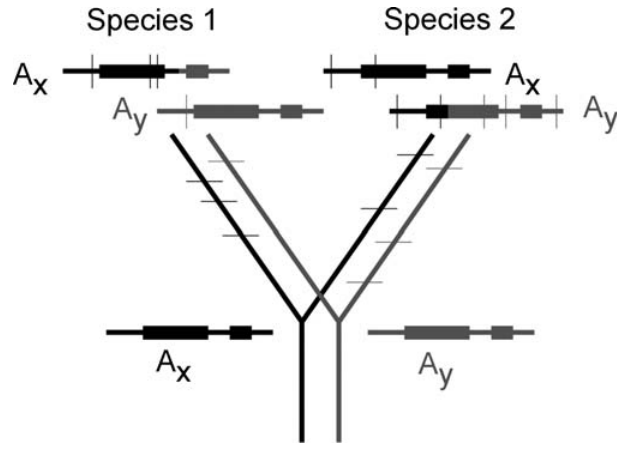
Figure 1. Sequence Diversity Expected at Neutral Sites at Different Distances from a Site under Balancing Selection The figure shows the dependence of diversity at neutral sites in a gene on the number of different alleles maintained ( n values) and the distance from the selected sites. A recombination rate of 1 cM/Mb is assumed, which is appropriate for humans, but much lower than the estimated rate for A. thaliana or maize. The example calculated is based on equations in the Appendix of [12], which are appropriate for selection at loci, such as MHC, where homozygous genotypes can be formed (e.g., a system with heterozygous advantage in which homozygotes are viable); note, however, that heterozygous advantage is unlikely to maintain very large allele numbers [35,82]. In the example shown, the turnover rate of alleles at the selected locus (or site) is assumed to be 10 (cid:1) 7 . (A) Shows predicted nucleotide diversity ( p ) between and within haplotypes of allelic classes (defined as having different alleles at the selected site or sites) for the case when 50 different alleles are maintained. (B) Shows the proportion of the overall diversity that is between allelic classes (analogous to F ST in a subdivided population), showing differentiation between the haplotypes across several kb when there are many alleles, even when recombination